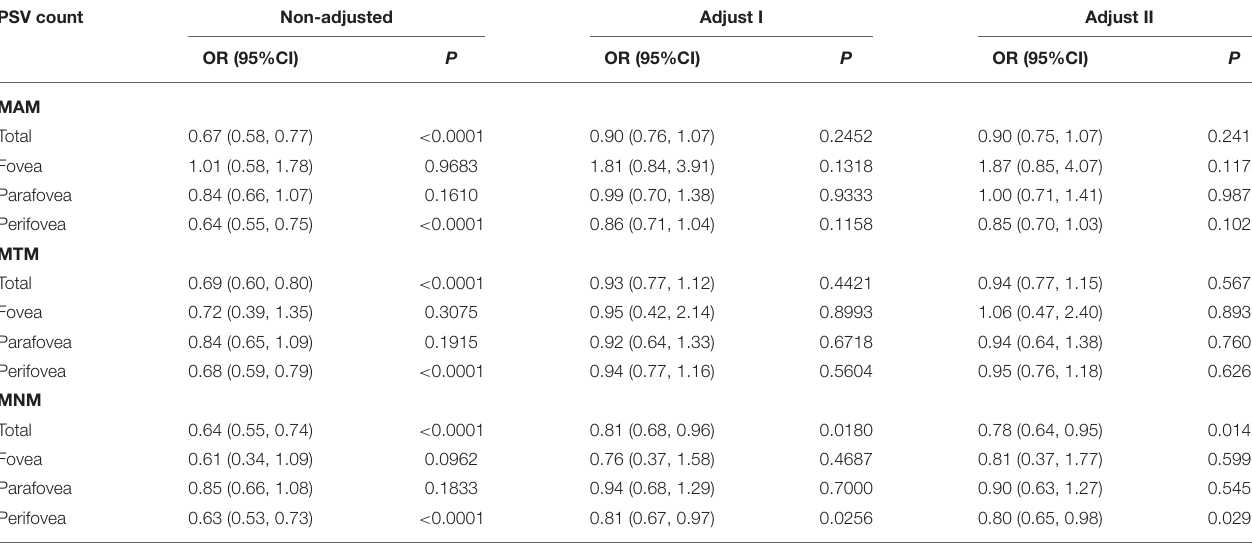
TABLE 4 | Relationship between PSV count and three different types of myopic maculopathy.